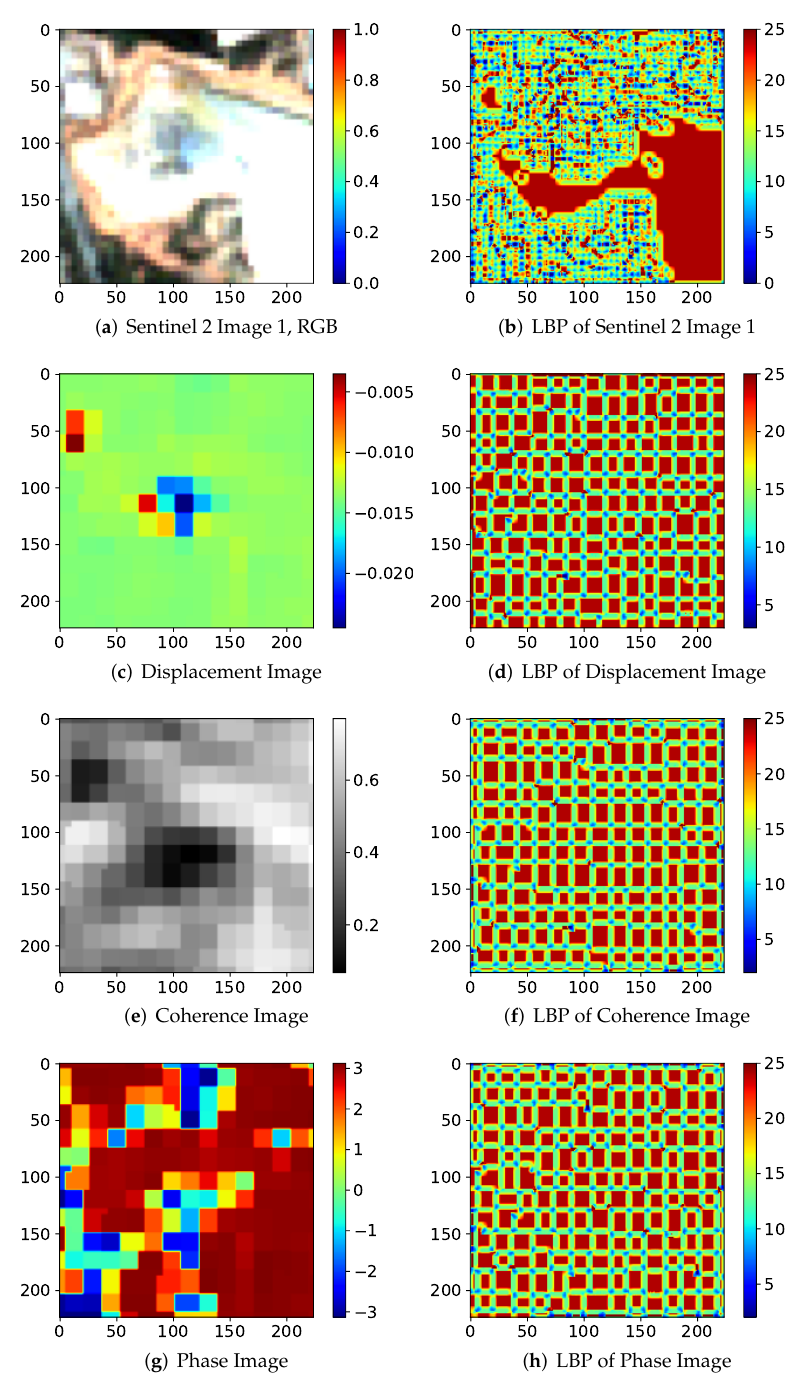
Figure 4. Local Binary Pattern of a positive blob in the